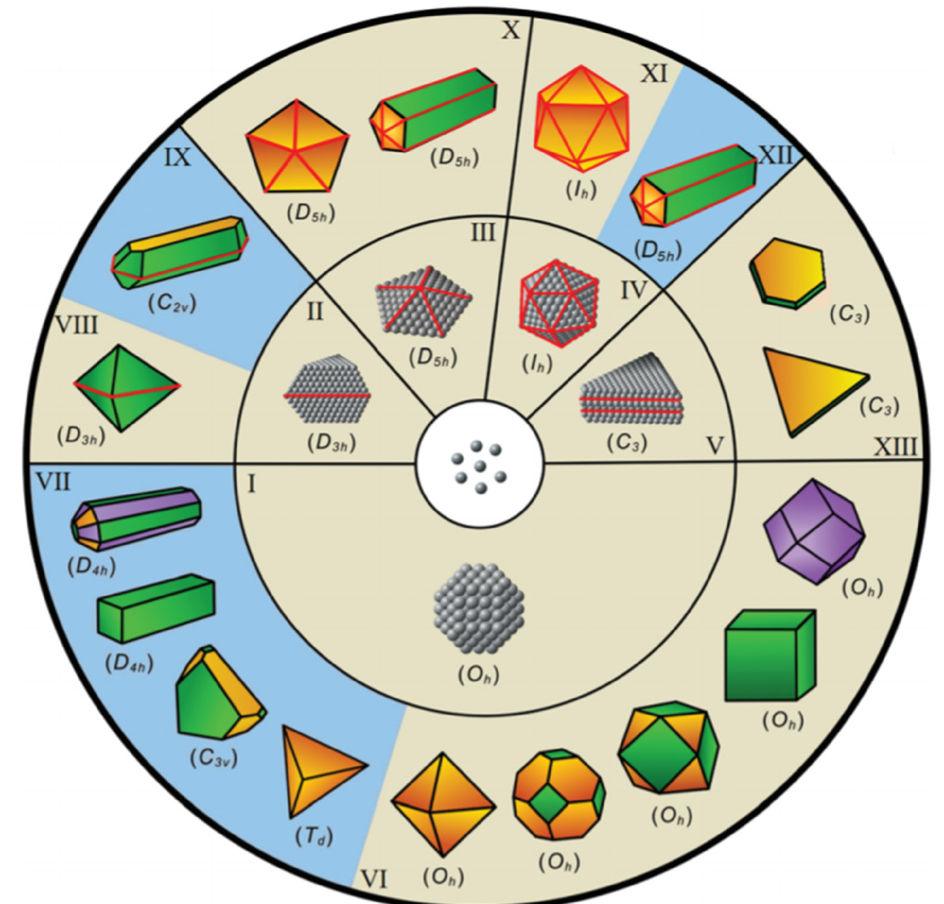
Figure 7 - Main stages of controlled synthesis of metal nanomaterials with face-centered cubic ( fcc ) structure: (i) nucleation (in the center); (ii) growth of nuclei into seeds (in the middle ring); and (iii) evolution of the seeds into the final nanocrystal (in the outer ring). The shape assumed by the nanocrystal depends on the structure of its corresponding seed and the relative binding affinities of capping agents to its distinct surface facets. The red lines indicate the twin defects or stacking faults in a seed or nanocrystal while the yellow, green and purple colors correspond to the {111}, {100}, and {110} facets, respectively. When there is a change in the background color, symmetry breaking is involved during the growth. Adapted with permission from ref (Gilroy et al . 2017) Copyright 2017 Royal Society of